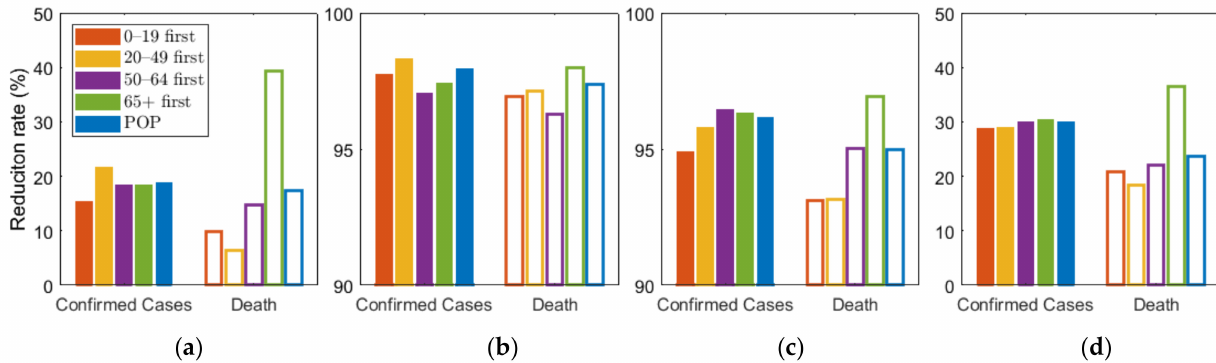
Figure 5. Effect of vaccination priority strategies for different SD levels ( a ) 0, ( b ) 1, ( c ) 2, ( d ) 3. Labels “0–19”, “20–49”, “50–64”, “65+” denote the vaccination priority strategies “0–19 first”, “20–49 first”, “50–64 first”, and “65+ first”, respectively. Table 6. Values of cumulative confirmed cases and deaths depending on SD level and vaccination priority strategy.